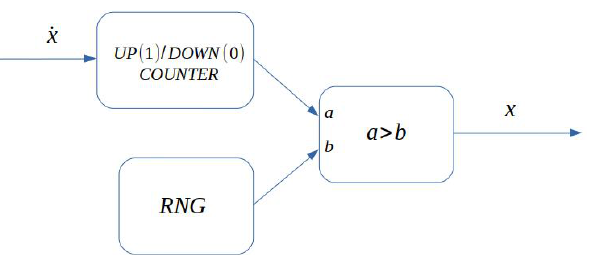
Figure 1. Basic implementation scheme of a SC integrator. Notice that both the input ˙ x ( t ) and the output x ( t ) are SEN